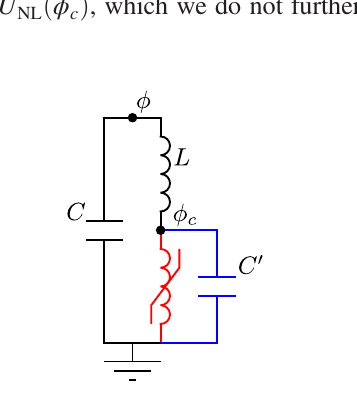
FIG. 4. Series combination of a linear inductance L and a nonlinear inductor (red) in parallel to a shunting capacitance C . The blue branch highlights the intrinsic capacitance C 0 of the small (regular case) or absent (singular